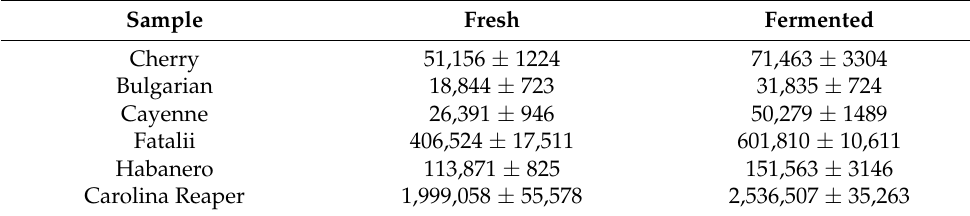
Table 4. Pungency of the studied samples in their fresh and fermented forms